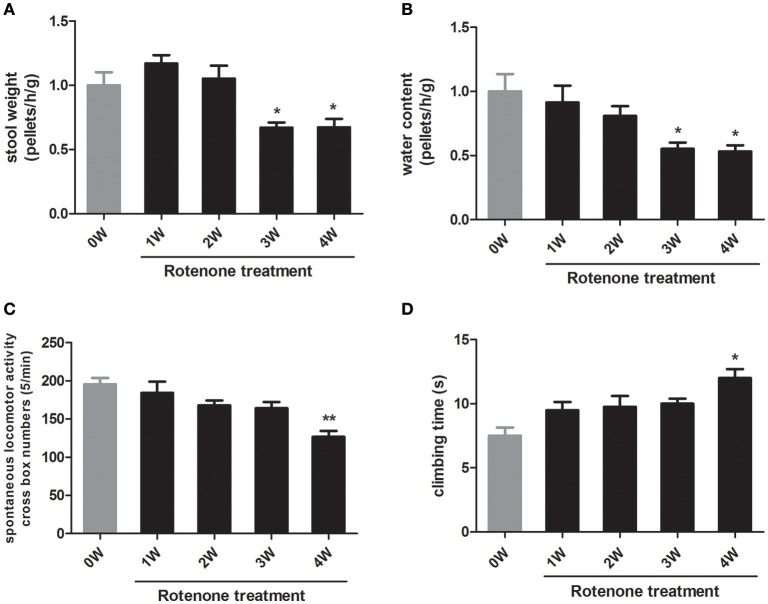
Longitudinal analysis of gastrointestinal and motor functions in rotenone-treated mice. (A) Fecal pellets in 1 h were collected and then recovered to initial status (0 week, baseline) (B) Water content of fecal pellets was calculated and then recovered to 0 week. (C) Spontaneous horizontal locomotor activity was determined by open-field test. (D) Motor coordination was determined by pole test. Data are expressed as means ± SEM of 5 mice, *p < 0.05, **p < 0.01 vs. 0W.